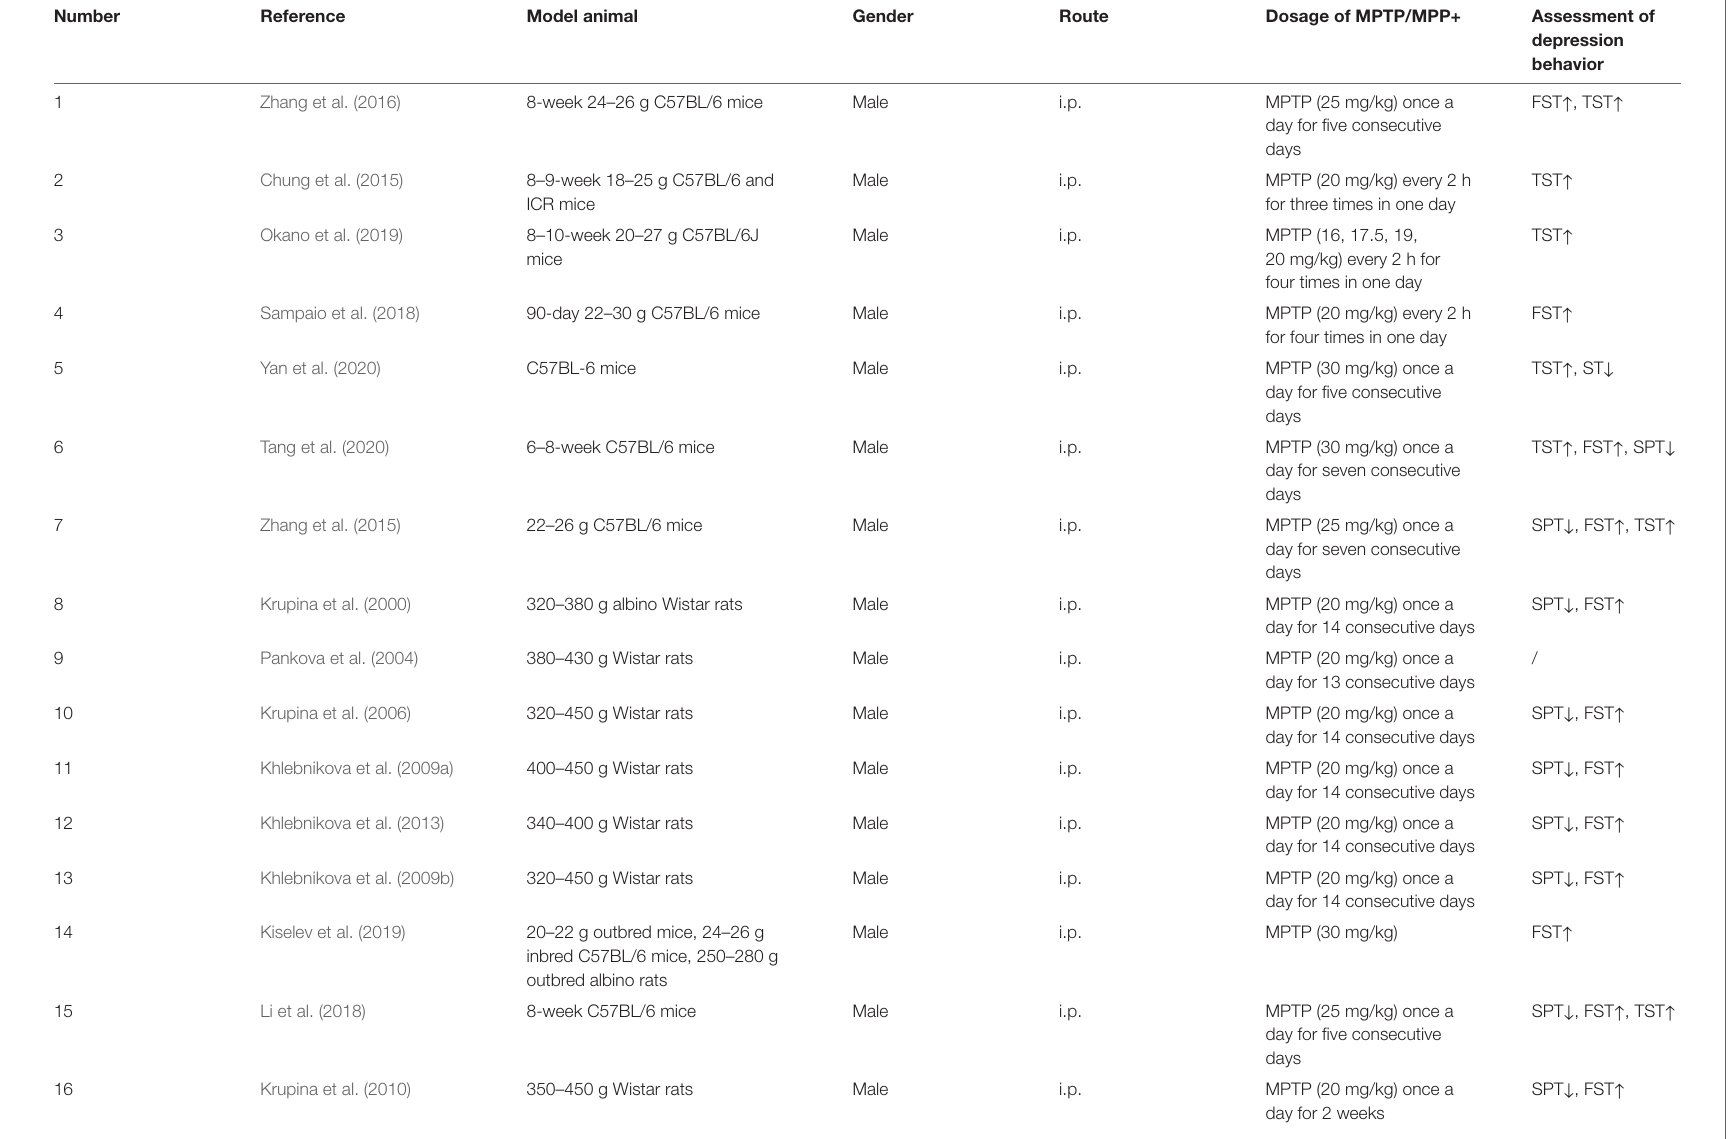
TABLE 1 | Summary of animal models of PD-related depression induced by